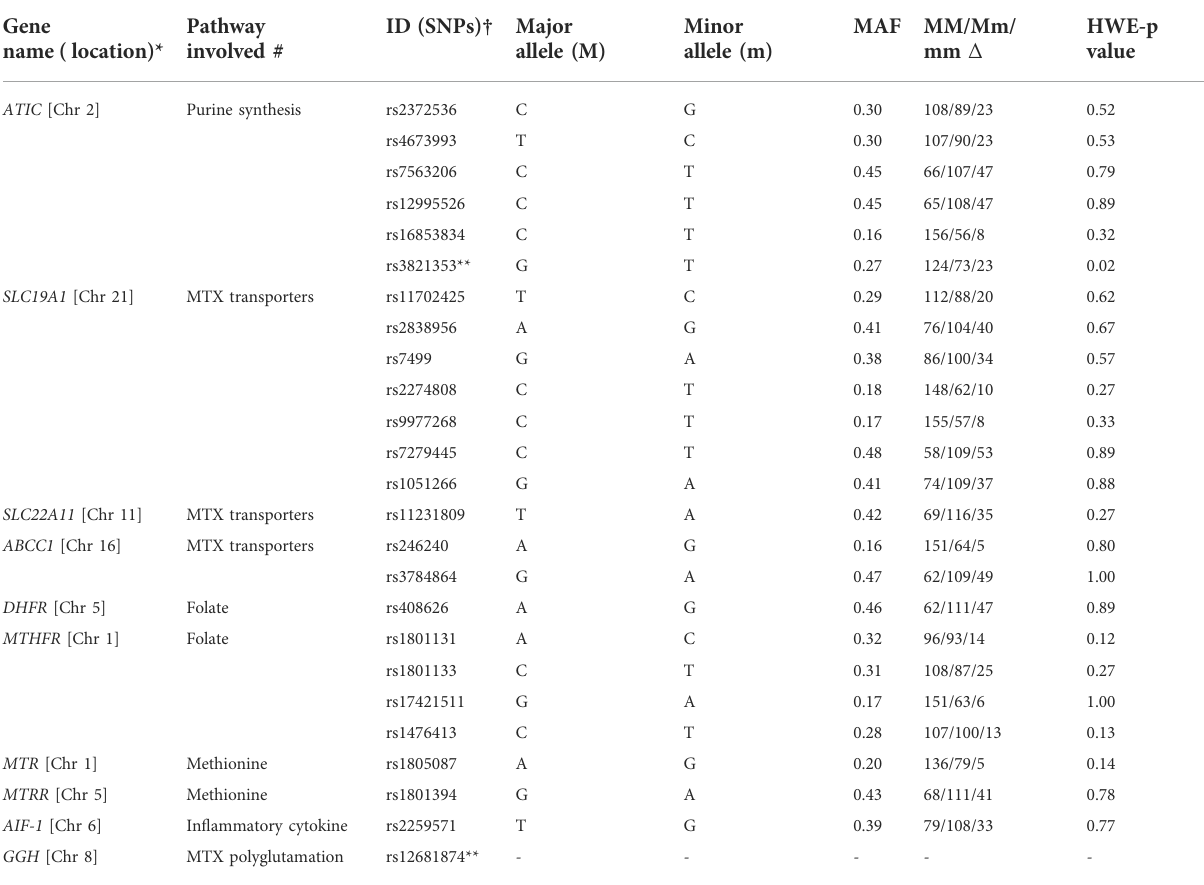
TABLE 2 Characteristics of the polymorphisms analyzed. Gene name ( location)*